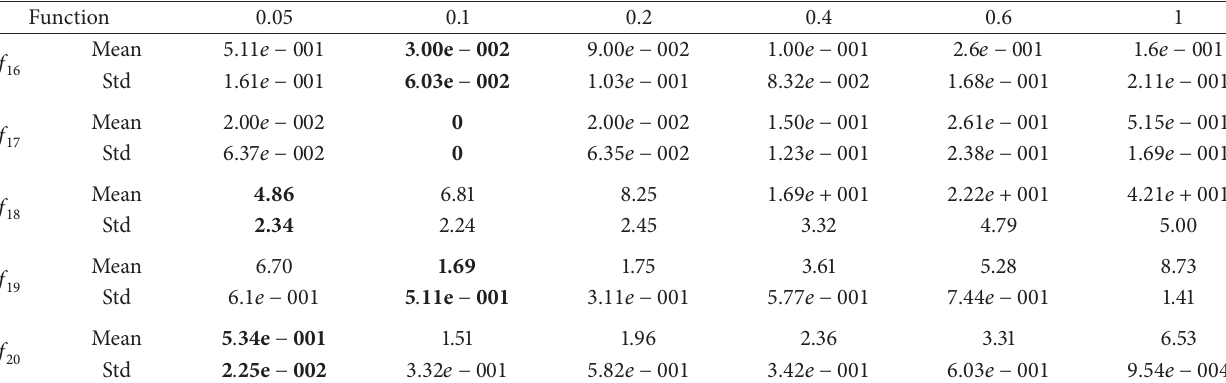
Table 5: Results of HABC SB on benchmark functions 𝑓 16 – 𝑓 20 with different CR. In bold are the best results.